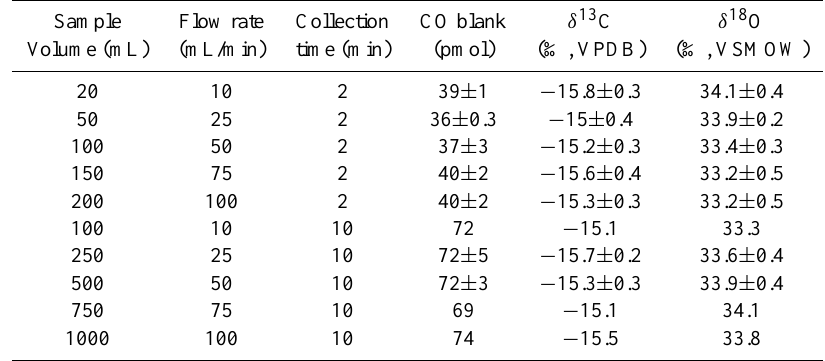
Table 2. Sch¨utze blank of the cryogenic system using zero air at a different flow rate.